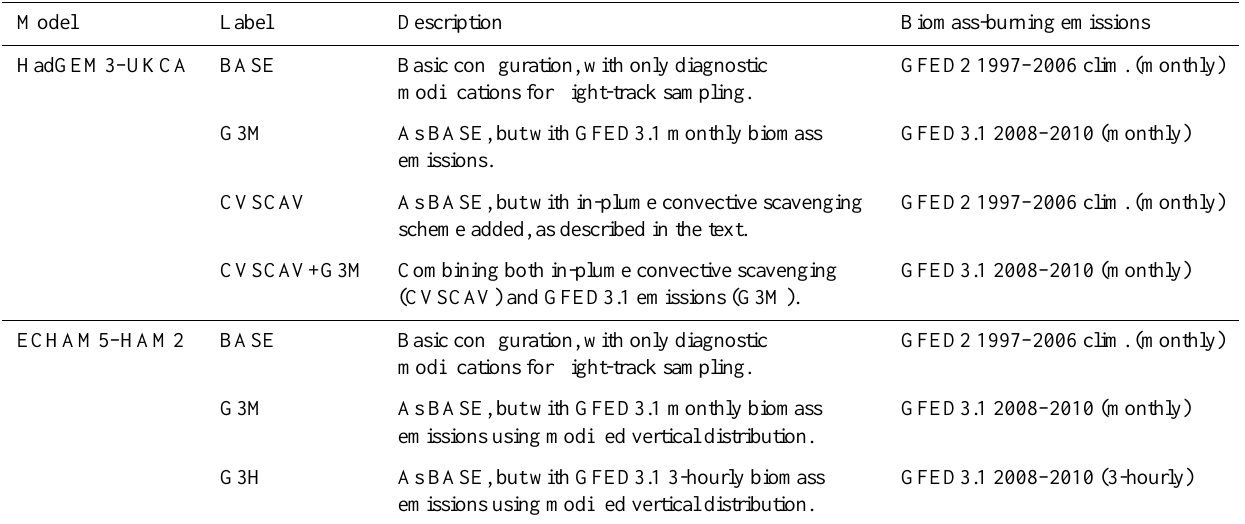
Table 2. Configurations and emissions used for model simulations of the HIPPO campaign. The inventory (GFED2 or GFED3.1) used for biomass-burning emissions is shown, along with the year for which these emissions are specified. Other emissions are taken from the AEROCOM Hindcast inventory, or (for additional gas phase emissions in UKCA) RCP